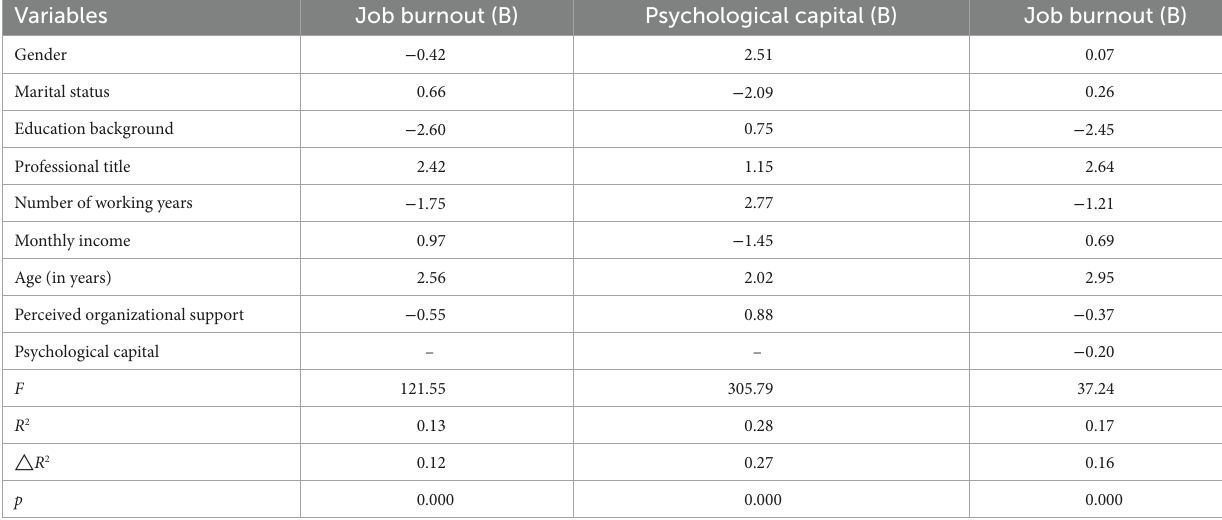
TABLE 3 Mediating effect analysis of psychiatric nurses’ psychological capital of psychiatric nurses ( n = 916, Shandong, China).